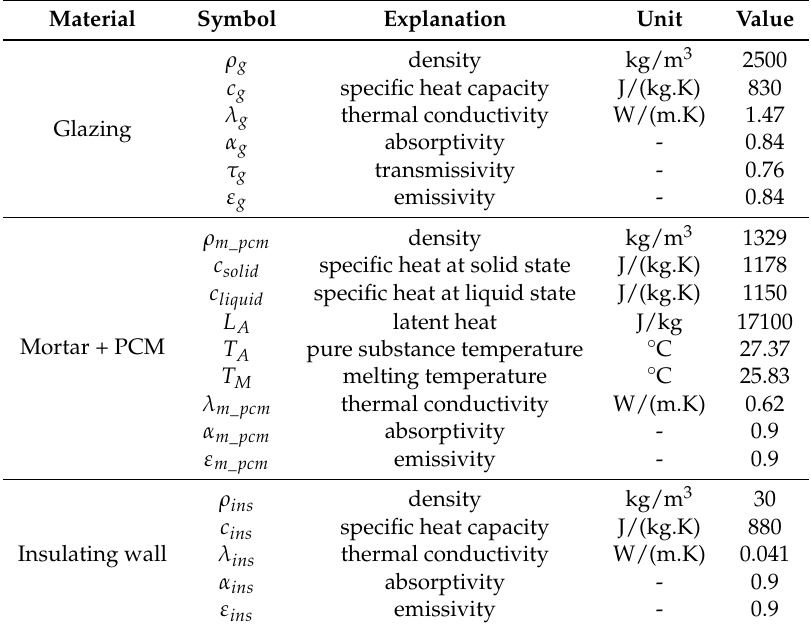
Table 2. Thermophysical properties of the materials